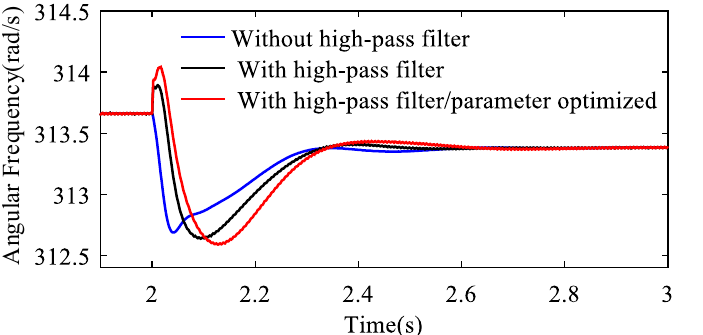
Figure 9. The simulation result of VSG angular frequency in three cases under the condition of load sudden increase.